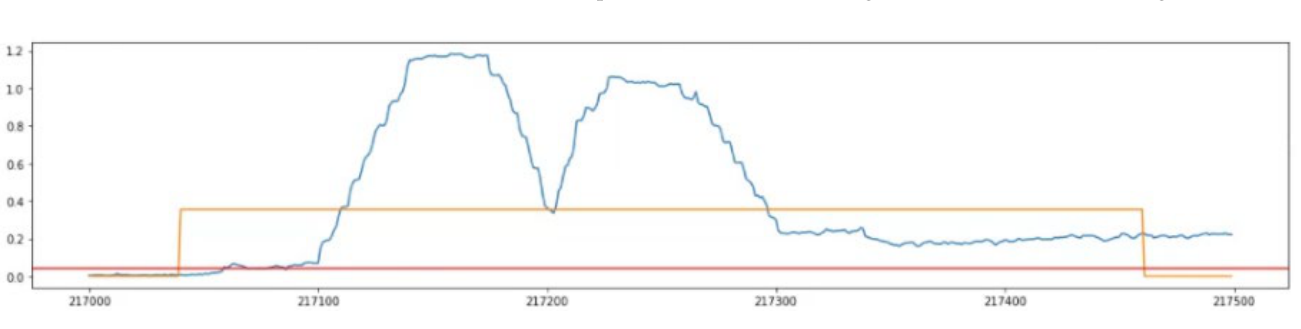
Figure 12. Section 3: 114,375~114,675 (Attack 16). The red line is the threshold, and when the blue line crosses the red line, we predict an attack. The orange line is the actual attack range.